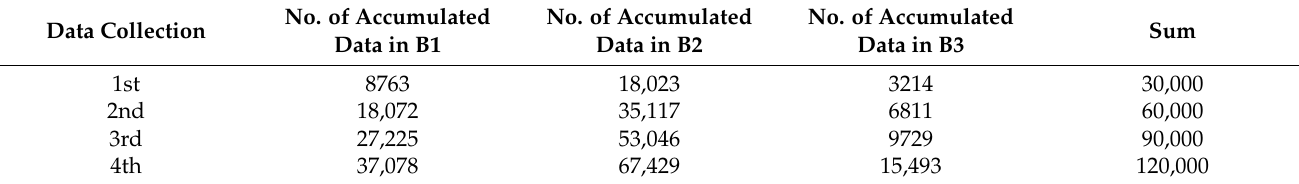
Table 3. Number of training dataset.